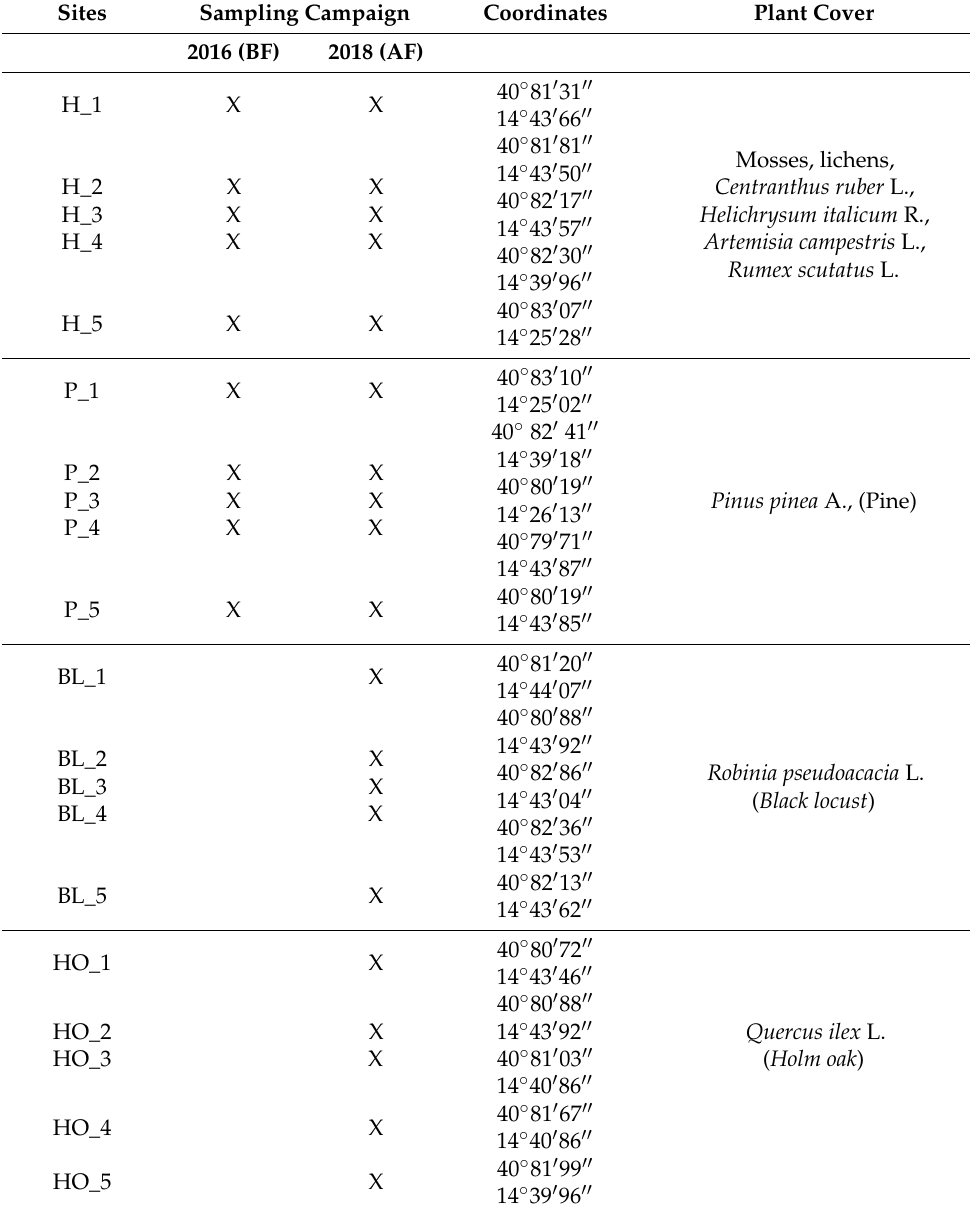
Table 1. Characteristics of the soils sampled inside the Vesuvius National Park.